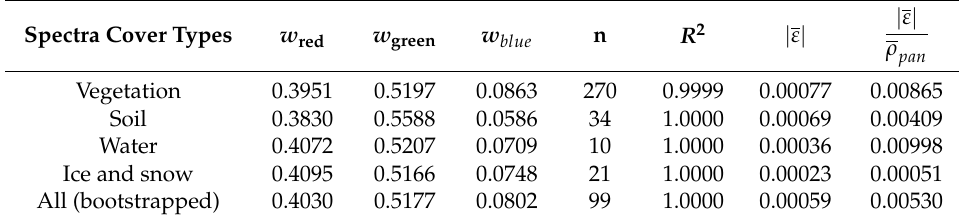
Table 1. Landsat 8 red, green and blue band spectral response function based (SRFB) spectral weights ( w red , w green and w blue ) derived by linear regression of the simulated Landsat 8 panchromatic reflectance against simulated red, green and blue reflectance, as Equation (4), for vegetation, soil, water, ice and snow, and all (bootstrapped) cover type spectra, n is the number of spectra used to generate each regression, R 2 is the regression coefficient of determination, | ε | is the mean absolute regression residual, | ε | and is the relative mean absolute regression ρ pan